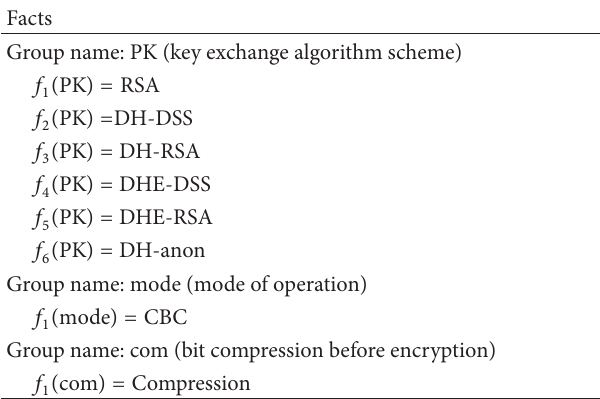
Table 6: The group of facts refers to asymmetric cryptography and common facts.